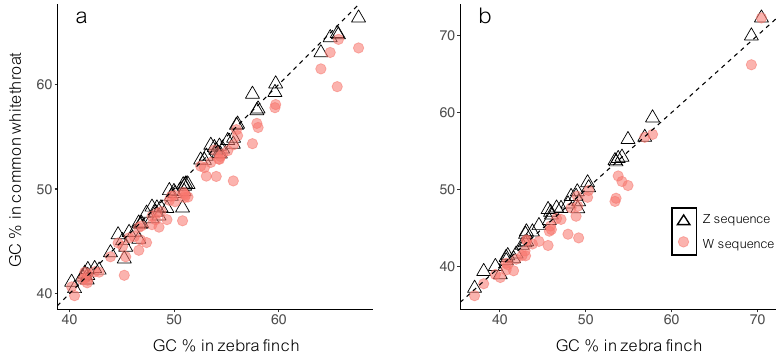
Figure 2. GC content (%) for common whitethroat gametologs plotted against the GC content for the zebra finch homologs. The black triangles are common whitethroat Z sequences and red circles are common whitethroat W sequences. ( a ) Neo-sex chromosome genes, corresponding to zebra finch chromosome 4A, and ( b ) ancestral sex chromosome genes, corresponding to zebra finch chromosome